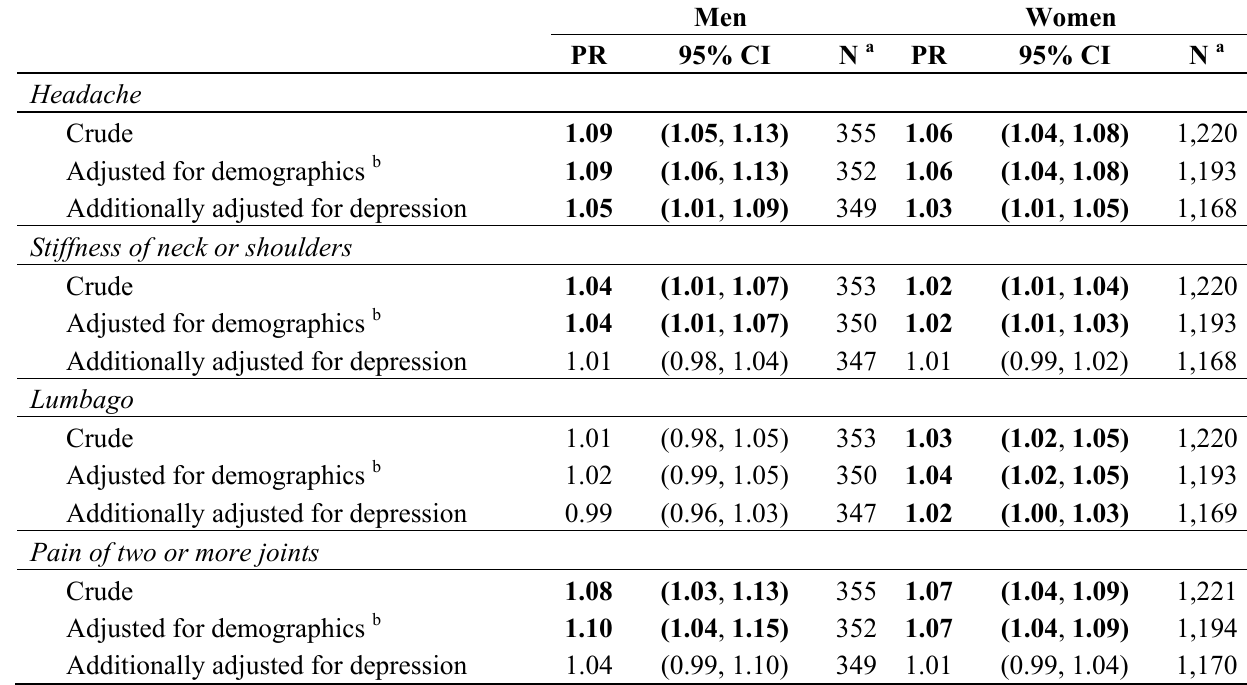
Table 3. Changes in the prevalence ratio associated with a 1-point increase in the work-related bullying